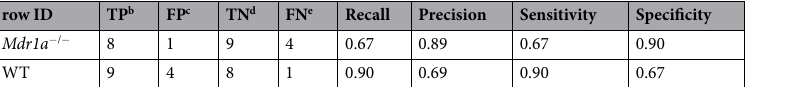
Table 1. Prediction statistics for the PLS-LDA a obtained from LC-MS data. a 5 latent variables were used for the PLS-LDA model, b True Positives, c False Positives, d True Negatives, e False Negatives. F-measure for mdr1a − / − is 0.76 and for WT is 0.78.Overall accuracy is 0.77 and Cohen’s kappa 0.55. All LC-MS mass data were used for the PLS-LDA model. No sample was excluded from the